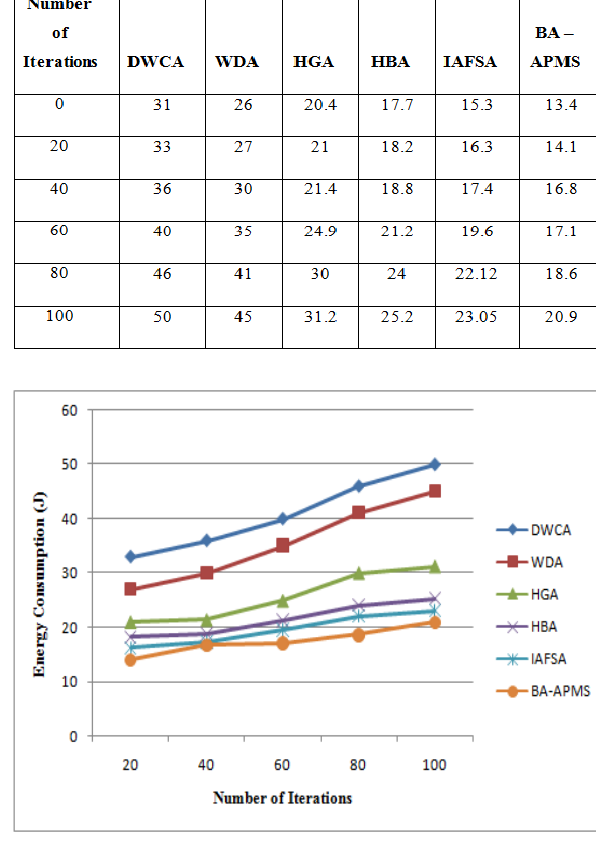
Figure 4. Energy Consumption